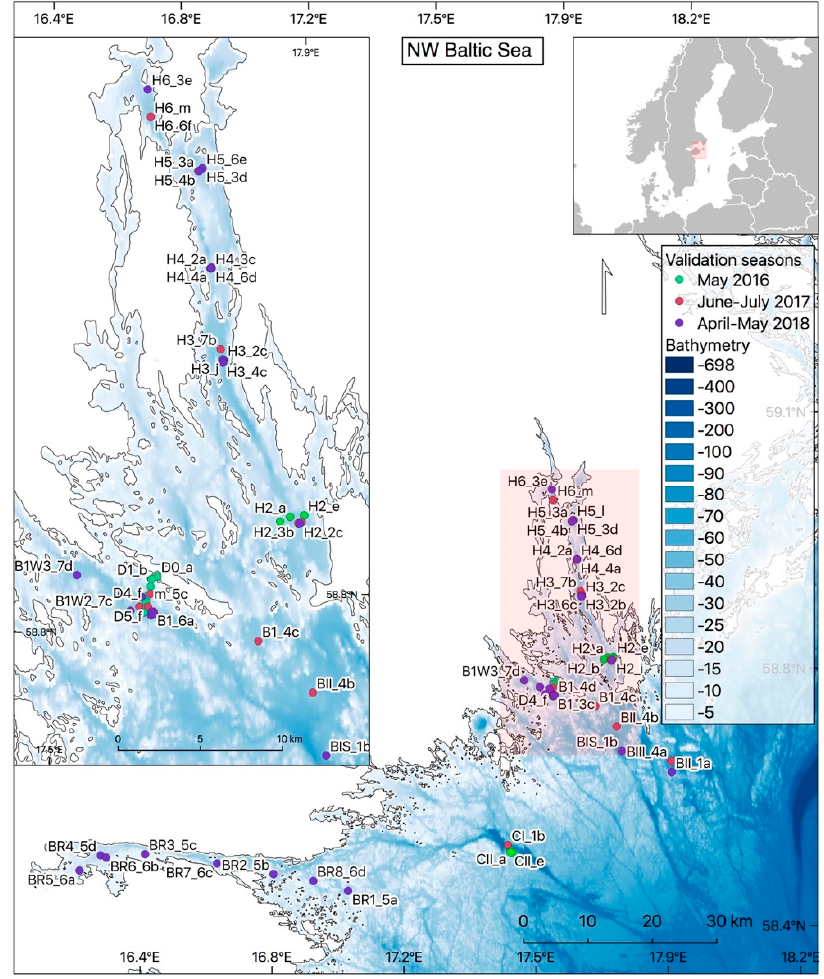
Figure 2. Location of in-situ sampling stations used for validation of Sentinel-3A during dedicated sampling campaigns in May 2016, June–July 2017 and April–May 2018. Bathymetry data [27]; HELCOM sub-basins [28]. European coastline shapefile (European Environment Agency, [29]). Country boundaries (Natural Earth, [30]).